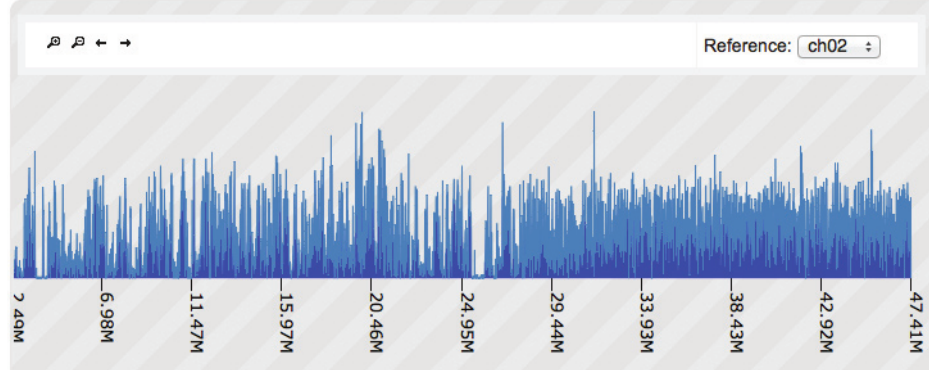
Figure 1. wigExplorer view of tomato variety Heinz chromosome 2. The top controls are designed to toogle between different references as well as zoom and pan. Peaks show SNP density of 1kb size bins. A change of SNP density can be observed around the 24M mark, with a slightly greater density of SNPs on the right, indicative of a potential introgression segment from another related